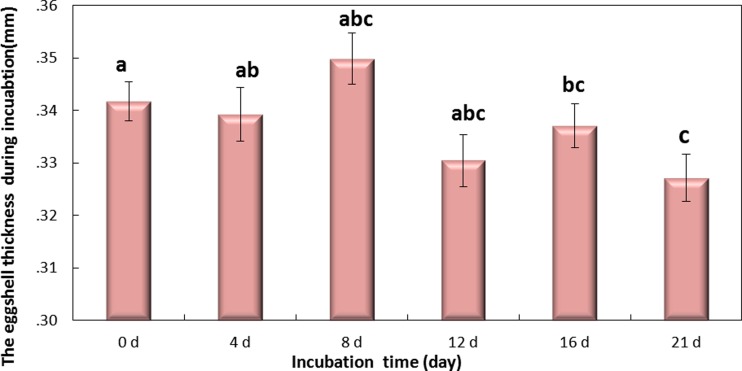
The thickness of eggshell on days 0, 4, 8, 12,16 and 21 during the incubation.If followed by different superscripts, values are significantly different (P < 0.05). Data were presented as mean ± SEM, n = 30.